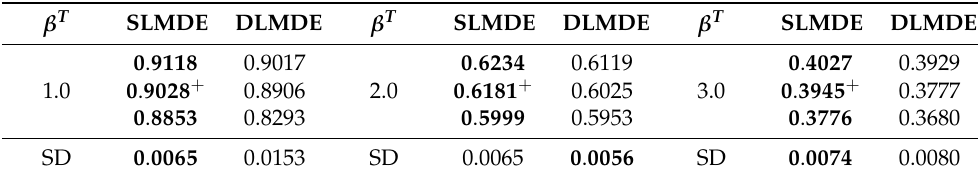
Table 3. Best, median, and worst HV values obtained by both methods are presented for Example 2 for different values of β T . The best performances are highlighted in bold font.